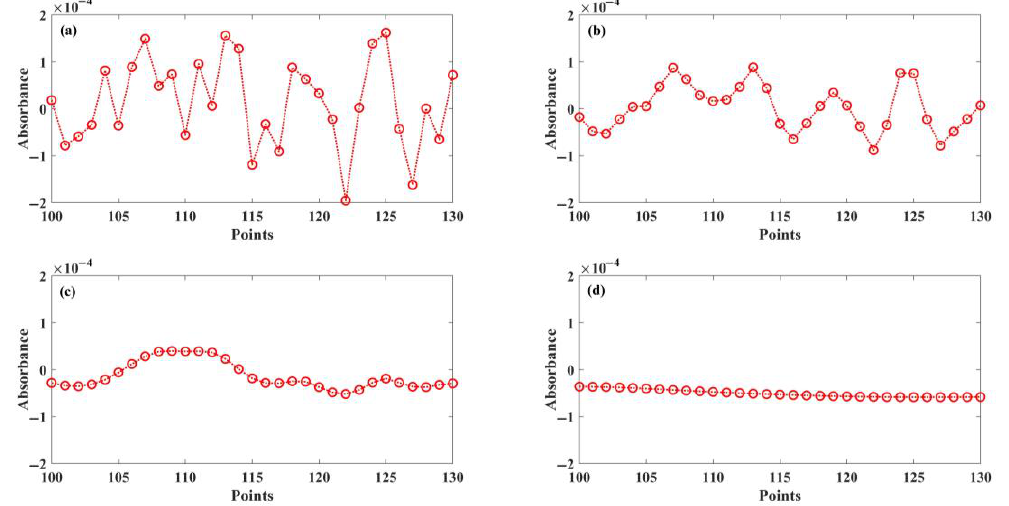
Figure 4. The result of analog signal processing with particle swarm algorithm. ( a ) The number of iterations is 0, ( b ) the number of iterations is 1, ( c ) the number of iterations is 5, and ( d ) the number of iterations is 80.